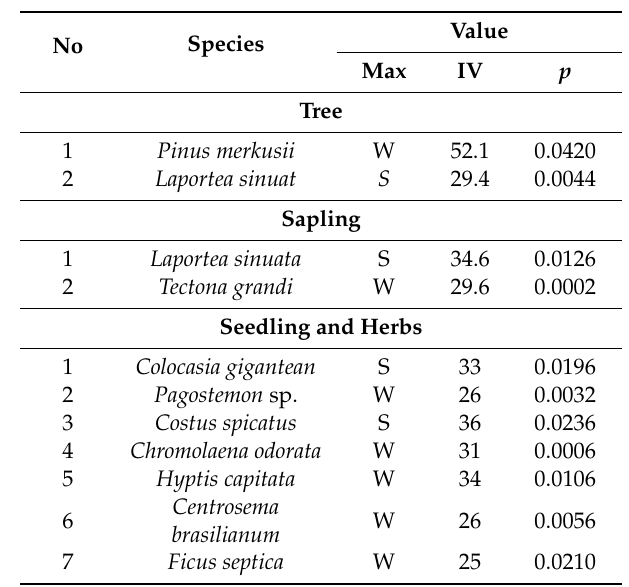
Table 5. Indicator species distinguishing Watujali and